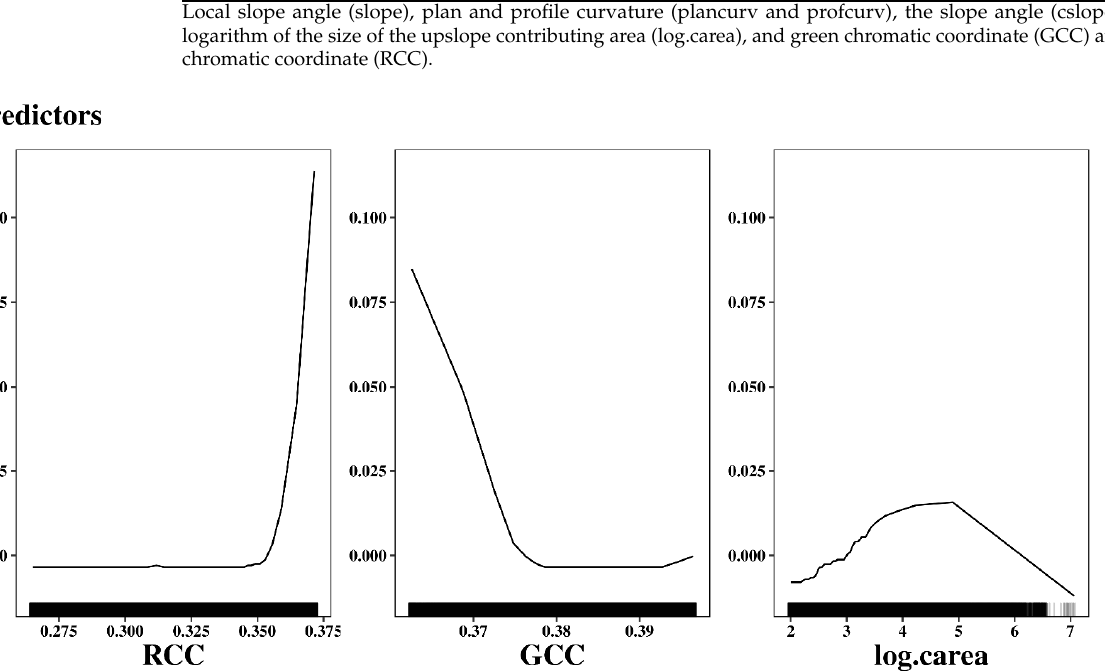
Figure 7. ALE plots of the most important predictors (green chromatic coordinate, GCC; red chromatic coordinate, RCC; logarithm of the size of the upslope contributing area, log.carea) for the SVM with margin sampling in repetition 1, epoch 20. Landslide maps predicted by SVM with margin sampling clearly depict many of the landslide-affected areas even after only five epochs (Figure 8). There is little change in the spatial pattern of mapped landslides after more than five epochs, which is consistent with the relatively stable model performances and variable importance reported above. Despite the visual similarities between epochs 5 and 10, it should be remembered that quantitative performances in terms of the mean and standard deviation of AUROC did substantially improve from epoch 5 to epoch 10, as hyperparameter tuning started to stabilize as well around epoch